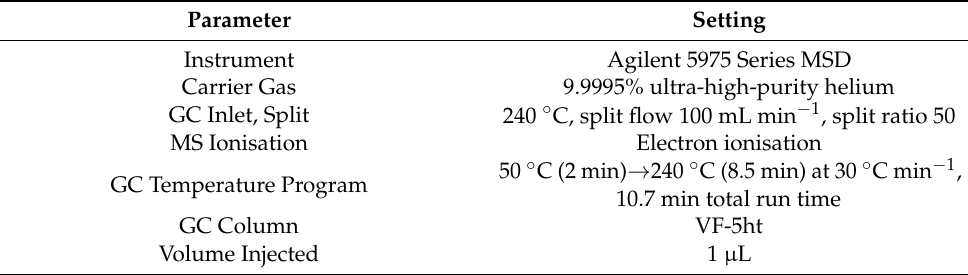
Table 1. Summary of GC-MS experimental